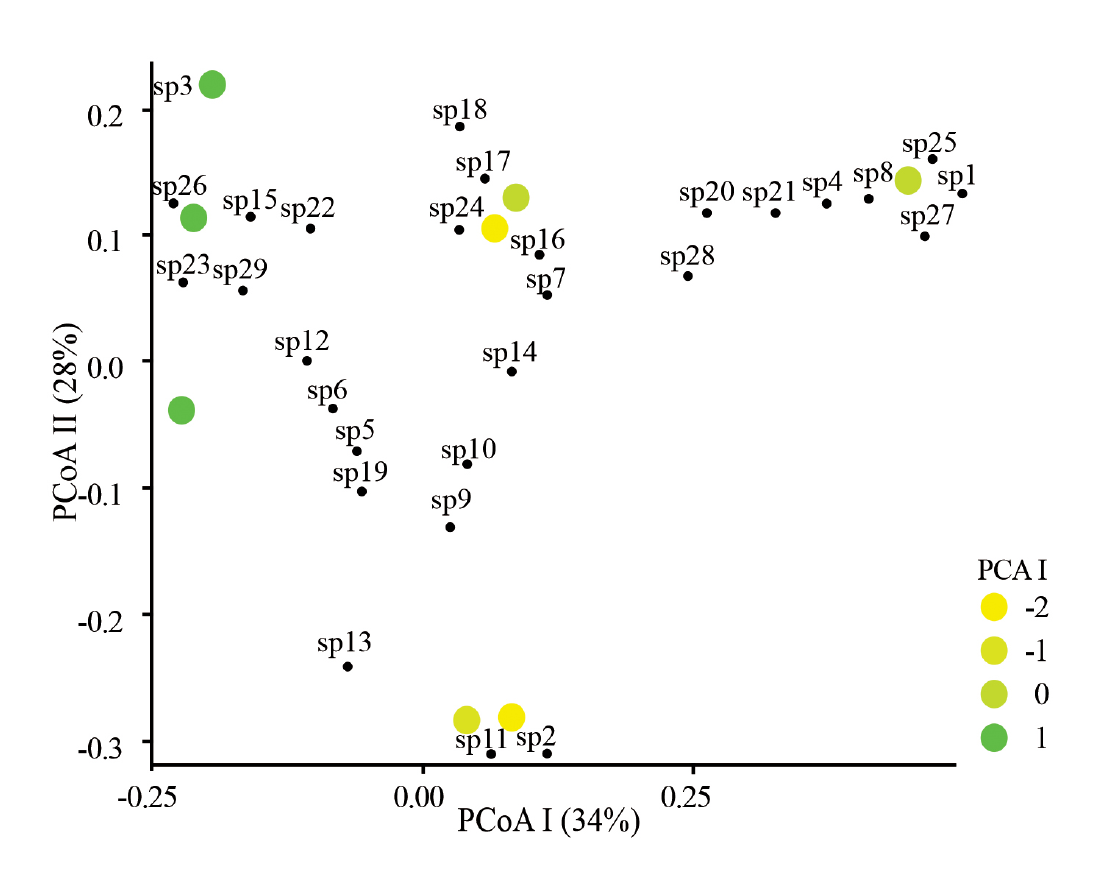
FIGURE 5 | Relationship between species composition and the first PCA axis, ordinated by a Principal Coordinate Analysis. Lighter colors represent sample points with less forest cover. The species corresponding to the codes are in Tab.